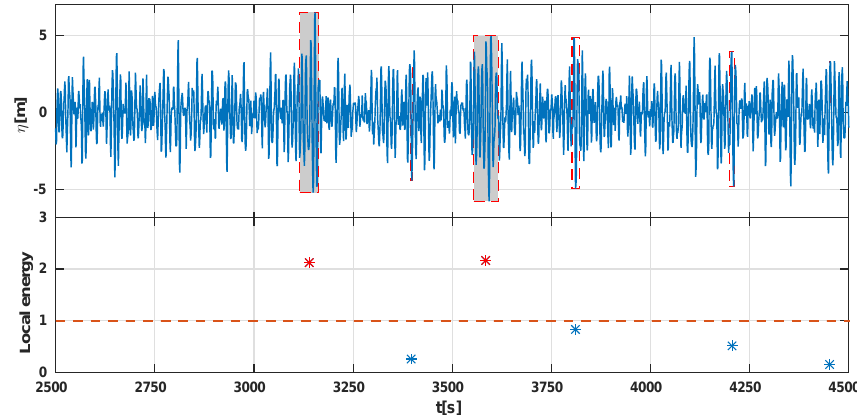
Figure 12. Case W100. Initial time signal in the interval t ∈ [ 2500 , 4500 ] s. The critical group events are shown in the shaded areas of the upper plot. The lower plot presents the amount of local energy signal of the recognized group events compared to the local energy threshold (dashed line). The local energy signal of the critical group events is above the threshold.